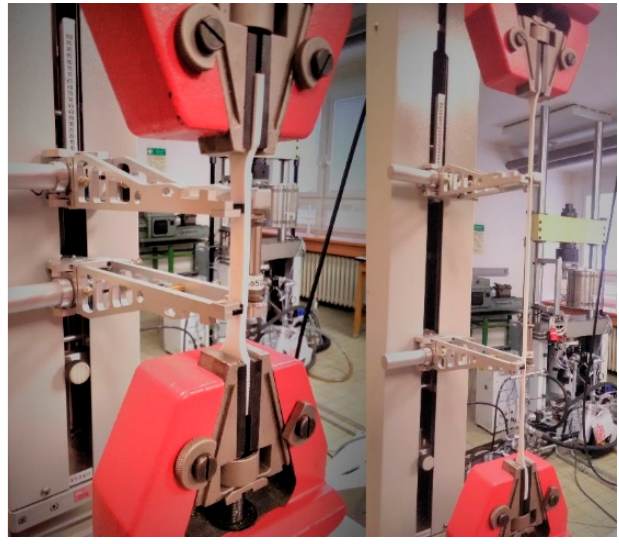
Figure 6. Test sample. Left: before loading, right: during the test.